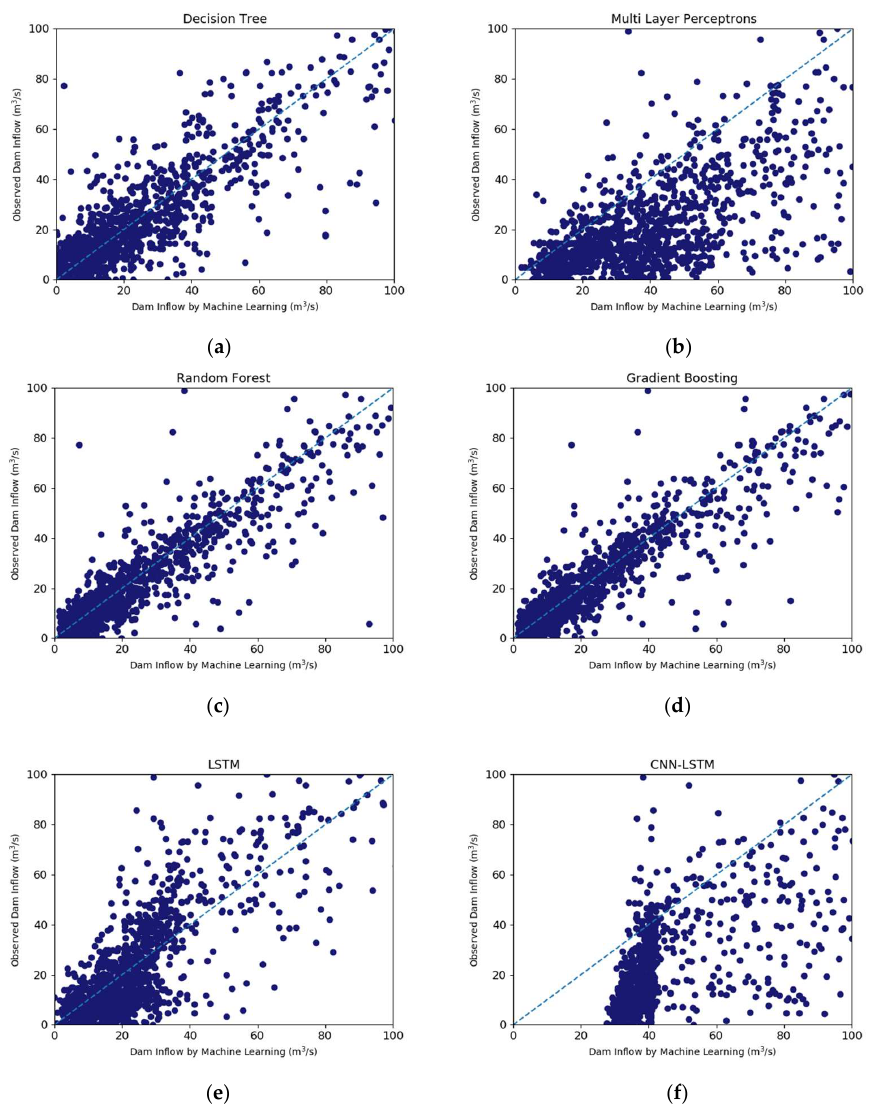
Figure 9. Comparison of dam inflow predicted by ( a ) decision tree, ( b ) multilayer perceptrons, ( c ) random forest, ( d ) gradient boosting, ( e ) LSTM, and ( f ) CNN–LSTM, and observed dam inflow below 100 m 3 /s with test data.